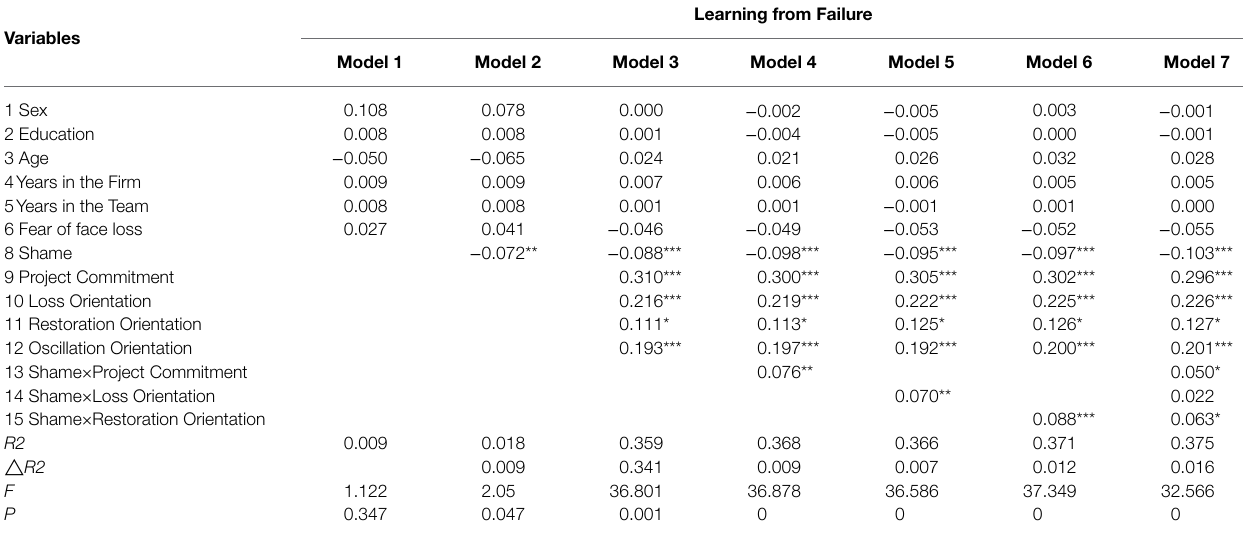
TABLE 3 | Results of regression analysis.